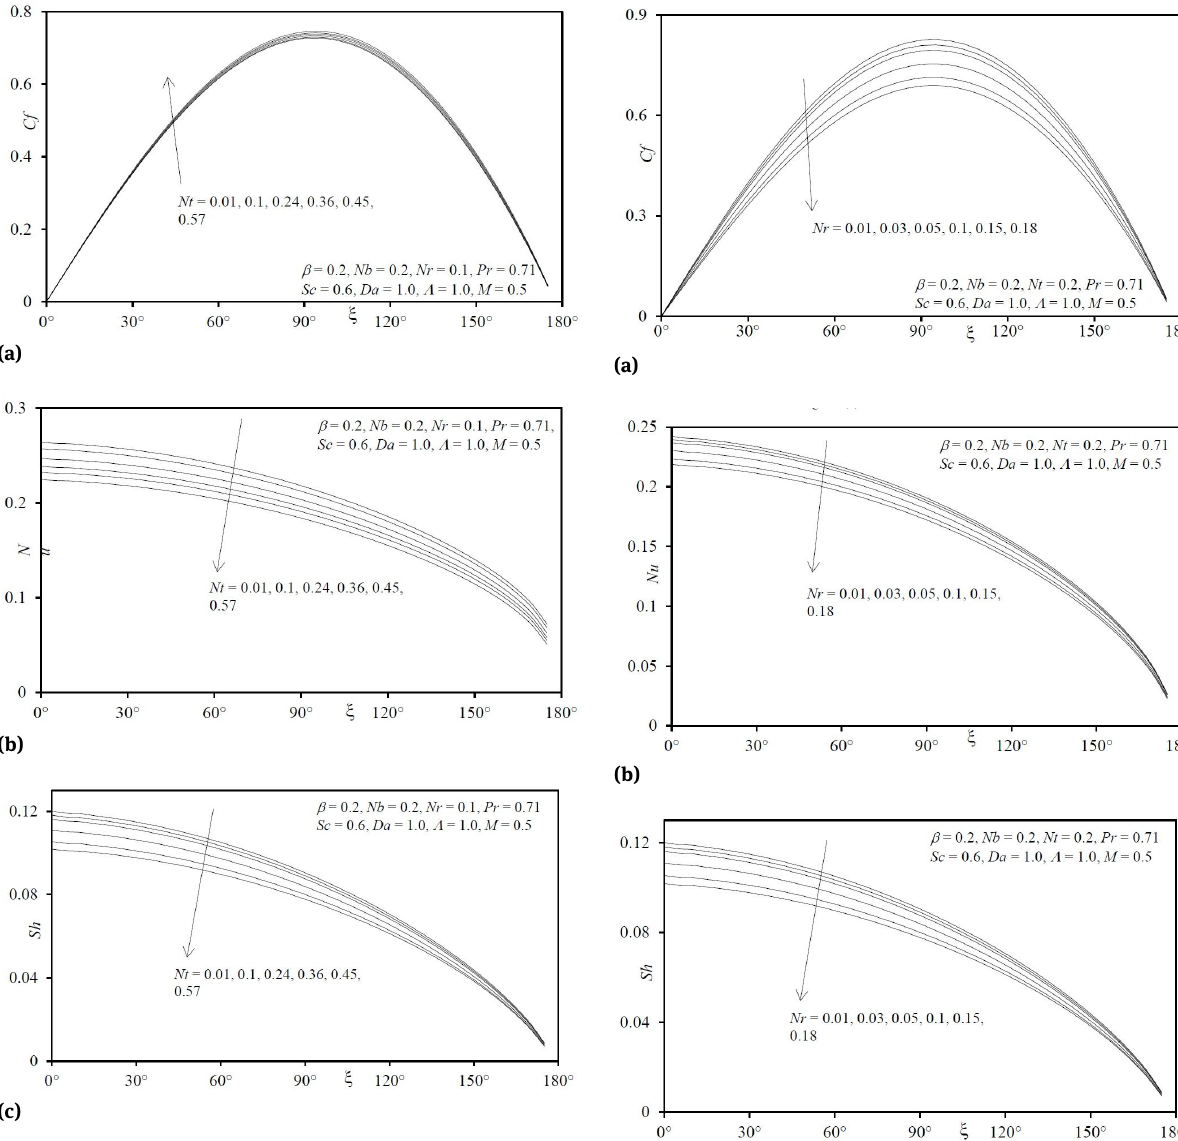
Fig. 10: (a) Influence of Nt on Skin Friction; (b) Influence of Nt on Nusselt Number; (c) Influence of Nt on Sherwood Number Figs. 8(a) – 8(c) depict the profiles for velocity ( f / ), temperature ( θ ) and concentration ( φ ) for increasing val- uesofmagneticparameter, M .Theparameter M represents